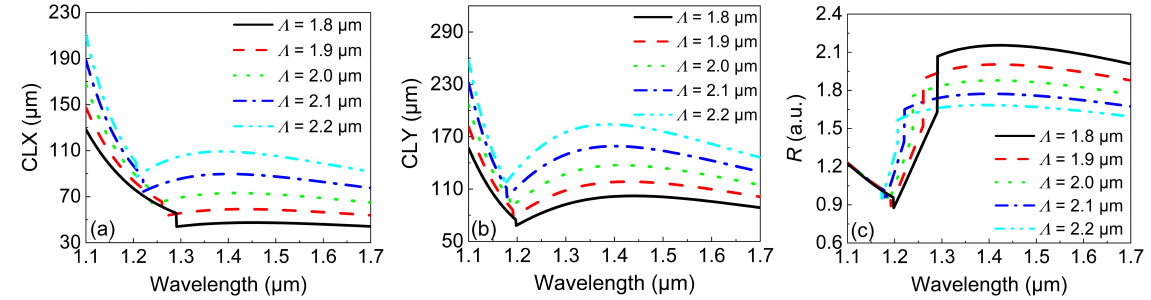
Figure 7. The variations in ( a ) the CLX and ( b ) CLY with the wavelength under different values of Λ . ( c ) The variations in R with the wavelength under different values of Λ